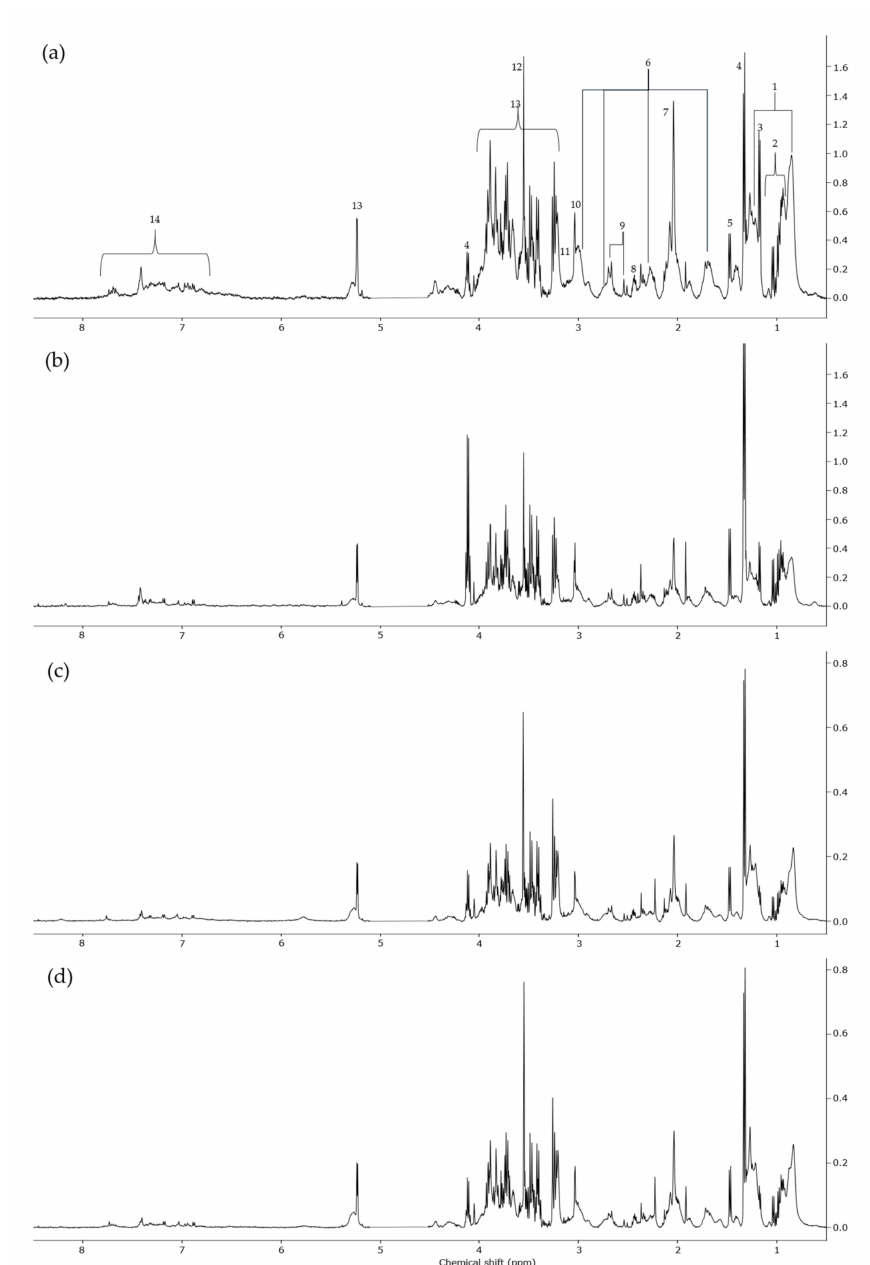
Figure 1. Comparison of the NMR spectra of plasma samples from pigs before and thirty minutes after the trauma injury or sham procedures: ( a ) before trauma; ( b ) after trauma; ( c ) before sham, and ( d ) after sham procedure. Peak assignments of some of the identified metabolite: (1) Low-density and very-low-density lipoproteins (LDLs and VLDLs), (2) isoleucine, leucine, valine, (3) 3-hydroxybutyrate, (4) lactate, (5) alanine, (6) lipids, (7) N -acetylglycoproteins ( N -AG), (8) glutamine, (9) citrate, (10) creatinine, (11) albumin (lysyl), (12) glycine, (13) glucose, (14) phenylalanine, tyrosine, tryptophan, and other aromatic